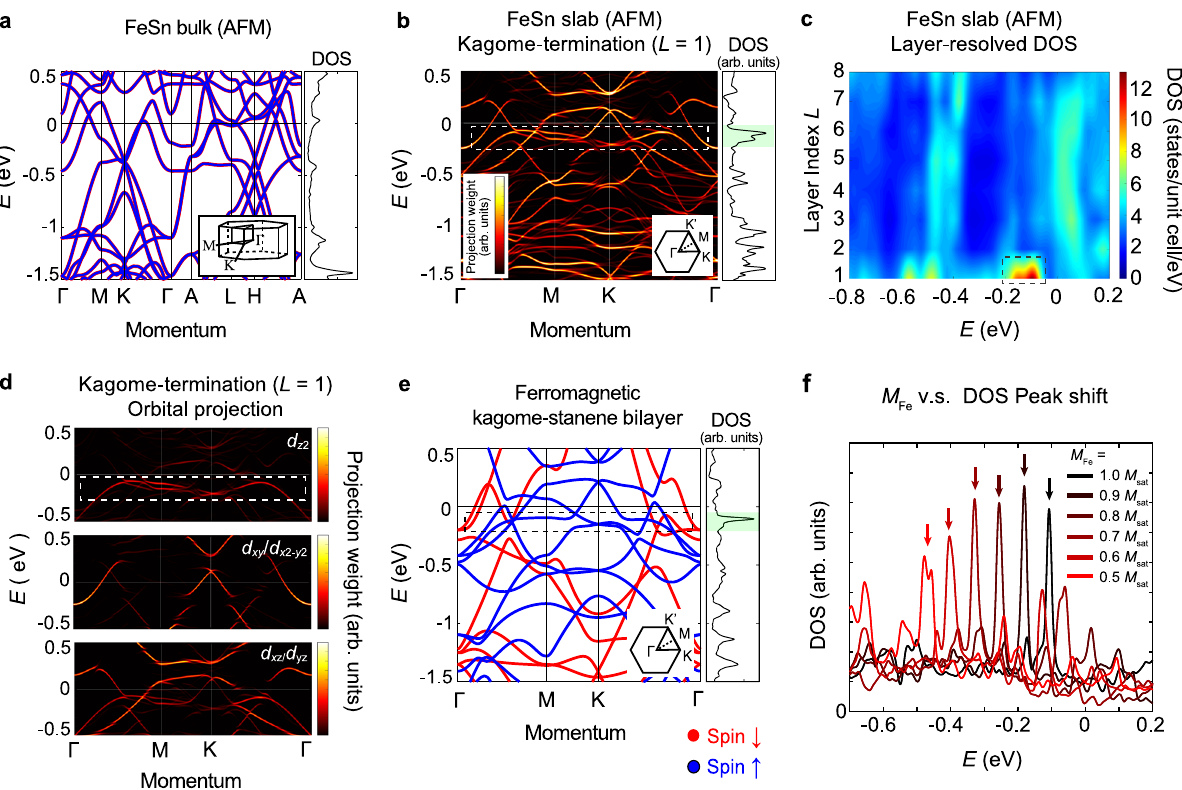
Fig. 4 Spin-polarized surface fl at band in FeSn. First-principles band structure calculations and DOS spectra of a bulk FeSn in the antiferromagnetic phase and b kagome-terminated surface of the eight-layer FeSn slab with the antiferromagnetic spin con fi guration. The intensity denotes Fe d -orbital projection weights in arbitrary units (arb. units). Insets in a , b show schematics of corresponding Brillouin zones. Spin down/up bands are color-coded with red/blue in a . The DOS peak and the fl at band in b are marked with the green-shaded box and the dashed line, respectively. c Layer-resolved DOS color map in the eight-layer slab. d Orbital projected band structure of b . e Band structure and DOS spectrum of a ferromagnetic kagome-stanene bilayer. f Average Fe spin moment ( M Fe )-dependent DOS spectra of the ferromagnetic kagome-stanene bilayer. The DOS peak associated with the fl at band shifts to higher binding energy as M Fe